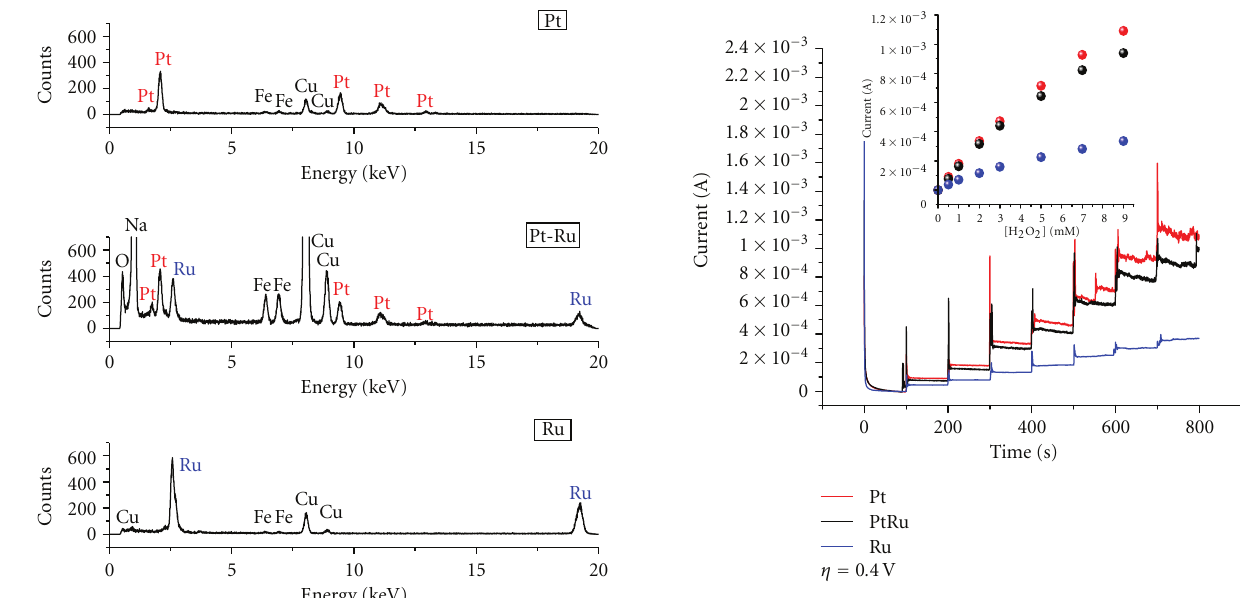
Figure 4: EDX characteristic peaks of colloidal Pt, Pt-Ru, and Ru nanoparticles; Fe and Cu corresponding to the instrumental artifact; Na and O corresponding to residues from the synthesis.